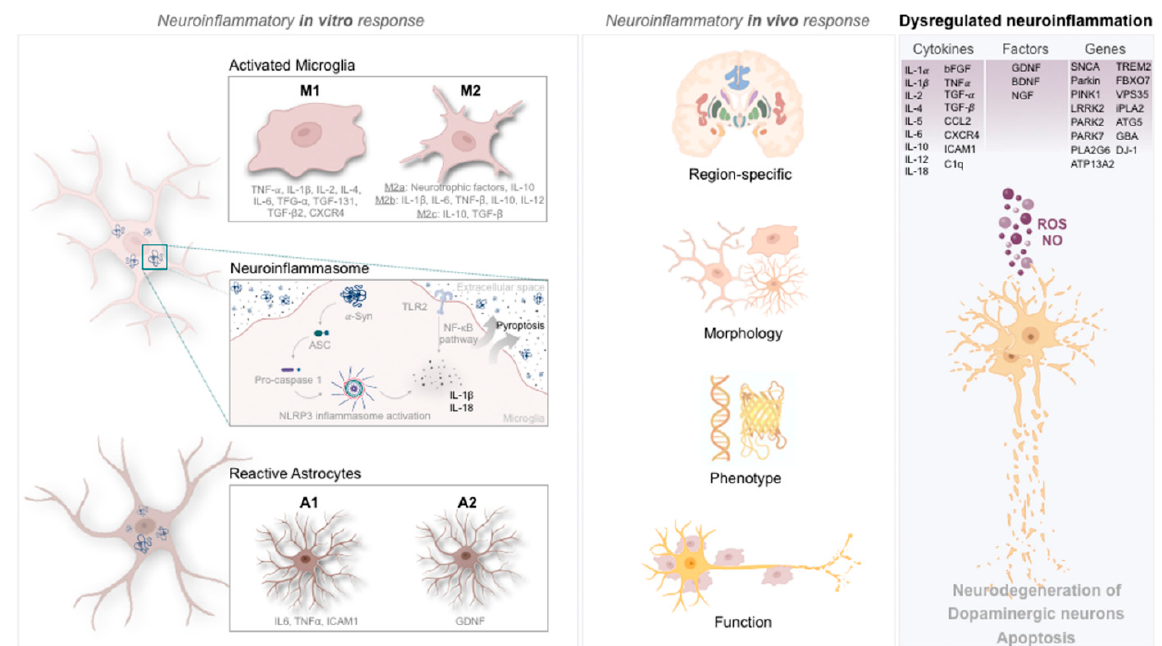
Figure 1. Neuroinflammatory response mediated by inflammatory cells and its impact on dopaminergic neurons in Parkinson’s disease (PD). DAMPs released by dying neurons and CCL2, a proinflammatory mediator, released by astrocytes or by misfolded or aggregated proteins (such as α -syn) trigger the initiation of an inflammatory response. Microglia and astrocytes change their morphology and gene expression and secrete several pro- and anti-inflammatory mediators to restore homeostasis. Canonically, activated microglia can be polarized into M1 (mainly proinflammatory cytokines promoting inflammation) or M2 phenotype (especially anti-inflammatory mediators stimulating repair and regeneration, which can be divided into M2a, M2b, or M2c). Similarly, reactive astrocytes acquire A1 and A2 phenotypes. In PD, the dysregulated cytokine release and the vast abundance of M1 and A1 phenotypes contribute to neurotoxicity and neurodegeneration. M1 phenotype is favorably adopted when DAMPs and CCL2 are released. In astrocytes, the presence of α -syn inclusions leads to the production of proinflammatory cytokines. However, this phenotypic and morphological characterization of inflammatory cells was established according to in vitro studies. NRLP3 (inflammasome) can detect aggregated substances (fibrillar α -Syn in microglia or detected by TLR2 receptors) or IL-1 β released by microglia, activating the NF-kB pathway and NLRP3 inflammasome, producing proinflammatory cytokines, such as IL-1 β and IL-18, which ultimately leads to pyroptosis. Thereby, in in vivo conditions, microglia and astrocytes exhibit wide heterogeneity. Despite the insufficient techniques to precisely identify the participant cells in inflammatory events in PD, their response is affected by the brain region, morphology, phenotype, and function. The inflammatory response occurring in PD mediated by the release of cytokine growth factors and genetic dysregulation produces reactive oxygen species (ROS) and nitric oxide (NO), leading to neurodegeneration of dopaminergic neurons. (Figure generated using BioRender.com (accessed on 1 June 2022)).